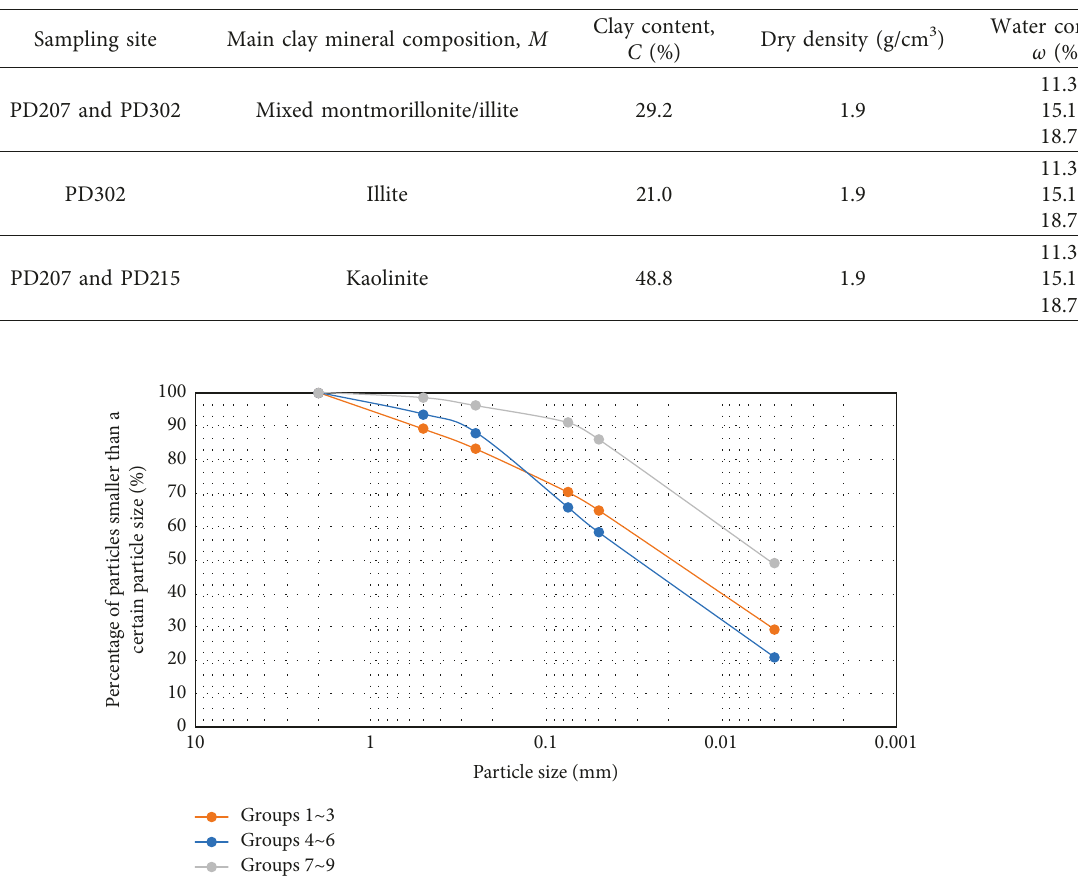
Figure 3: Specimens after remolding: (a) Groups 1 ∼ 3; (b) Groups 4 ∼ 6; (c) Groups 7 ∼ 9. Table 1: Physical properties of remolded specimens.